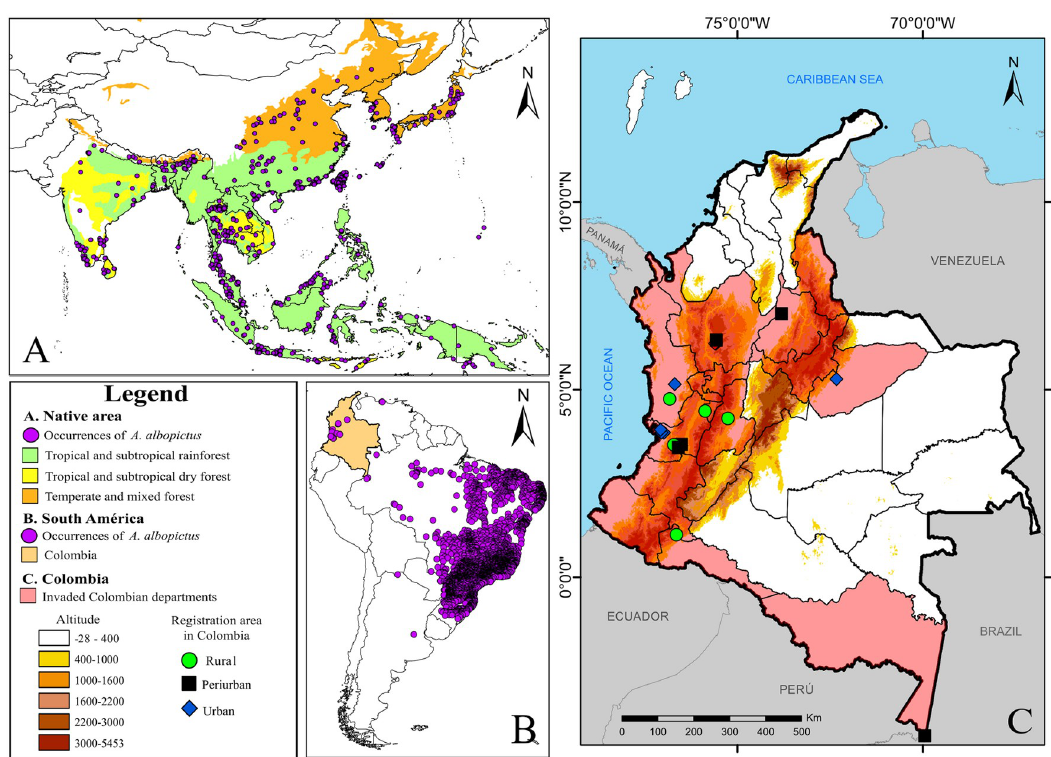
Fig 1. Occurrences of A . albopictus in: A . Native area (first dataset), B . South America (second dataset), and C . Colombia, employed in the ENM. The maps were built using the free and open source QGIS software version 3.10.11 (https://www.qgis.org/en/site/about/ index.html) and shapefiles were obtained from the free and open source DIVA-GIS site (https://www.diva-gis.org/gdata).